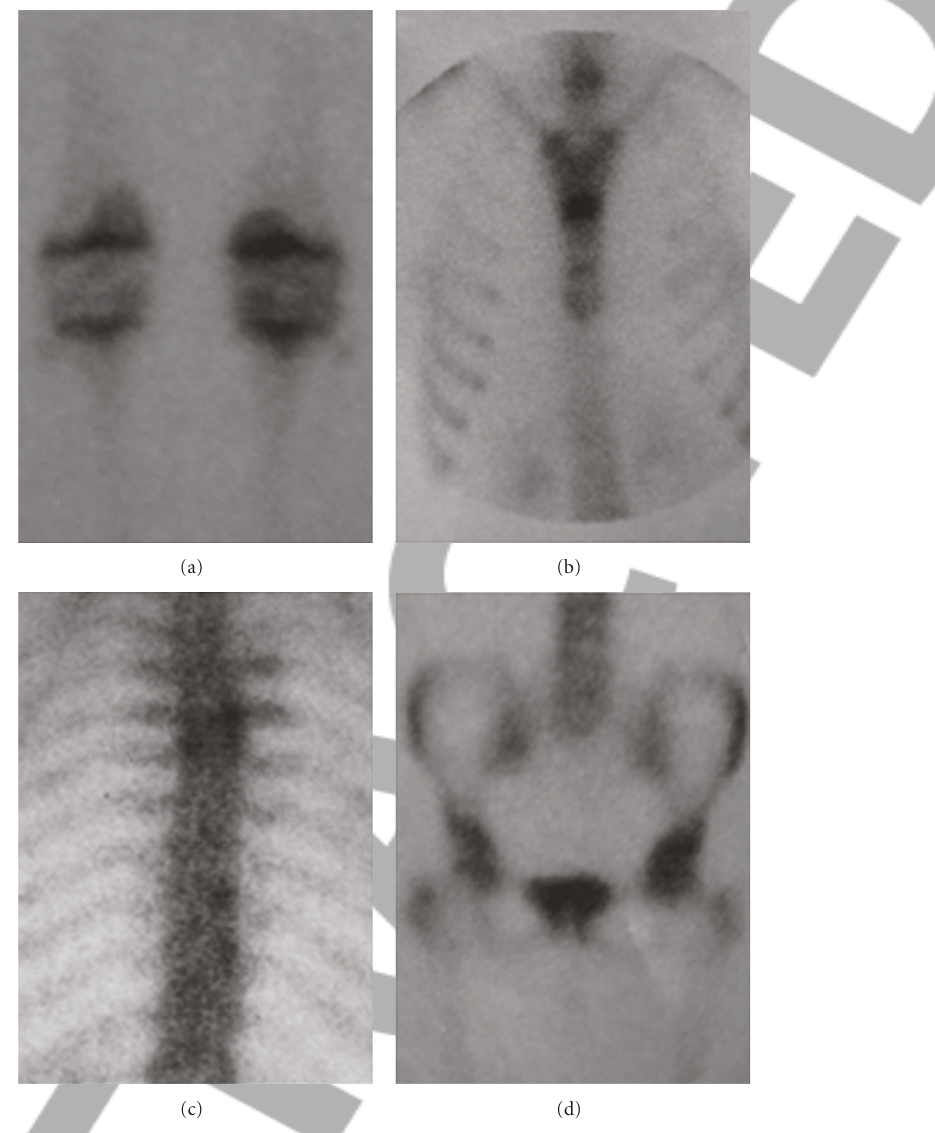
Figure 3: Bone scan at the disease presentation. Since the radiological investigation for bone lesions in this area proved negative, the increased uptake in both knees (a) was attributed to synovitis. Increased uptake was also demonstrated in the sternum (manubrium and body synchondrosis) (b), in thoracic vertebrae (c), and in the left hip